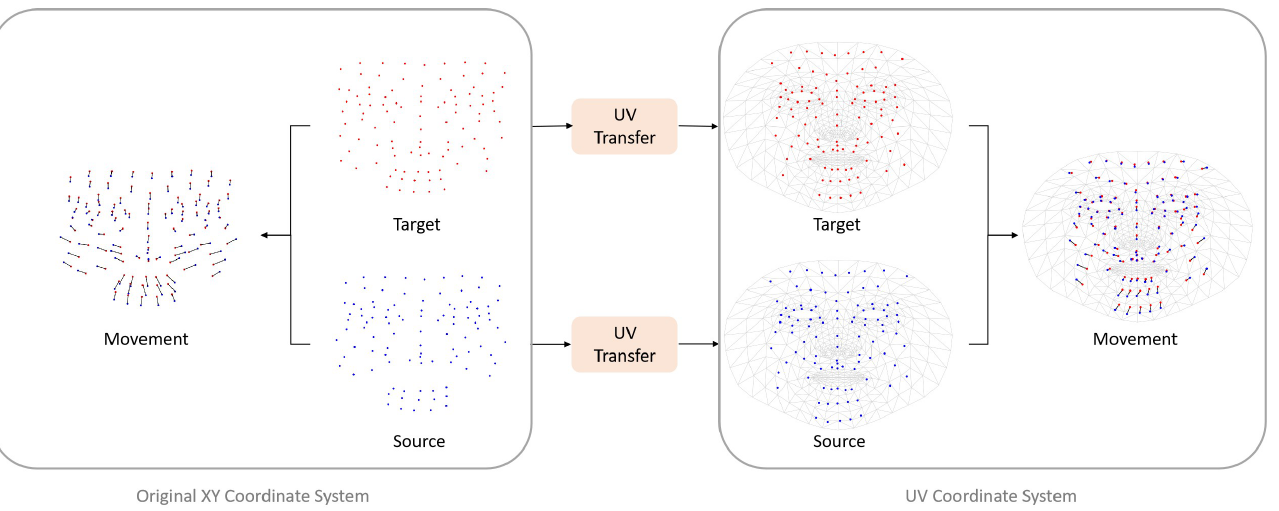
Figure 4. Movement comparison in different coordinate